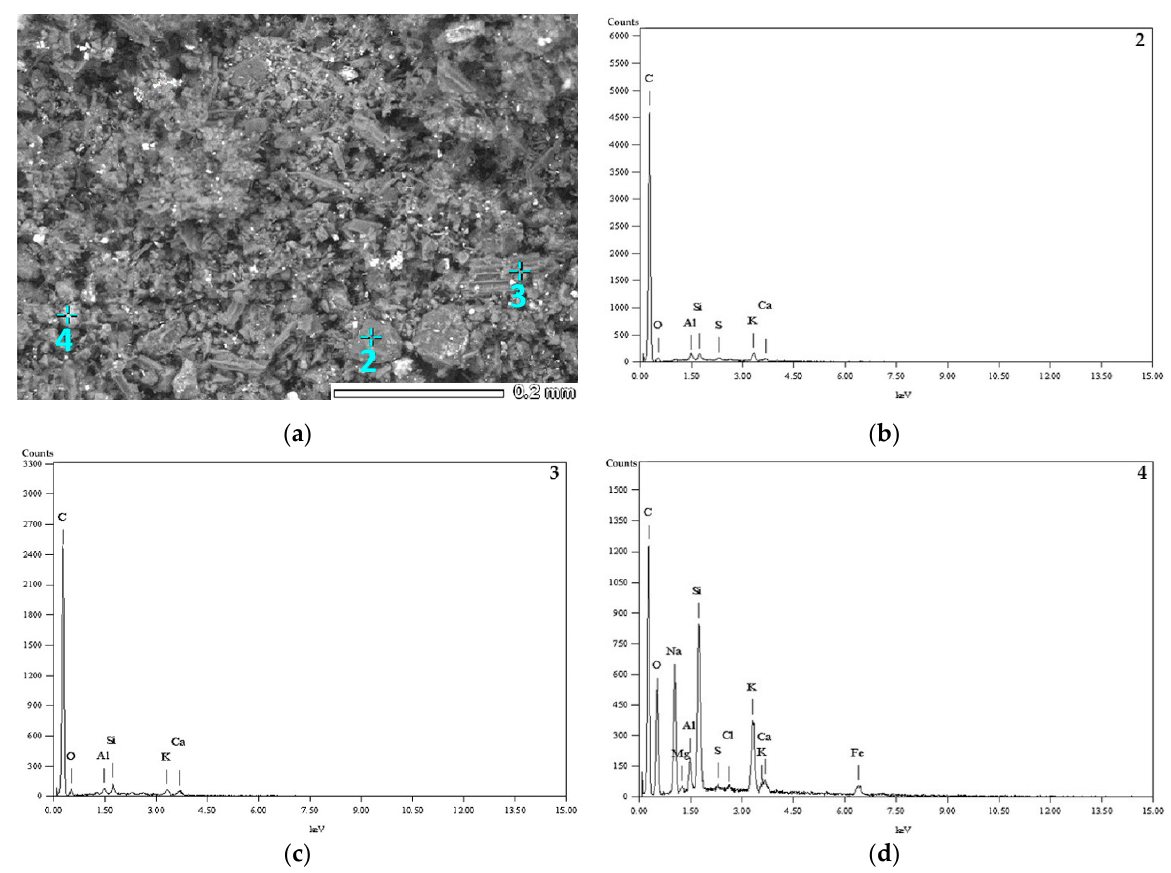
Figure 5. Dispersion energy spectra of X-rays (EDS) for certain area (2, 3, 4) of activated carbon, ( a ) photo of analyzed sample of activated carbon; ( b – d ) spectra for points 2–4.